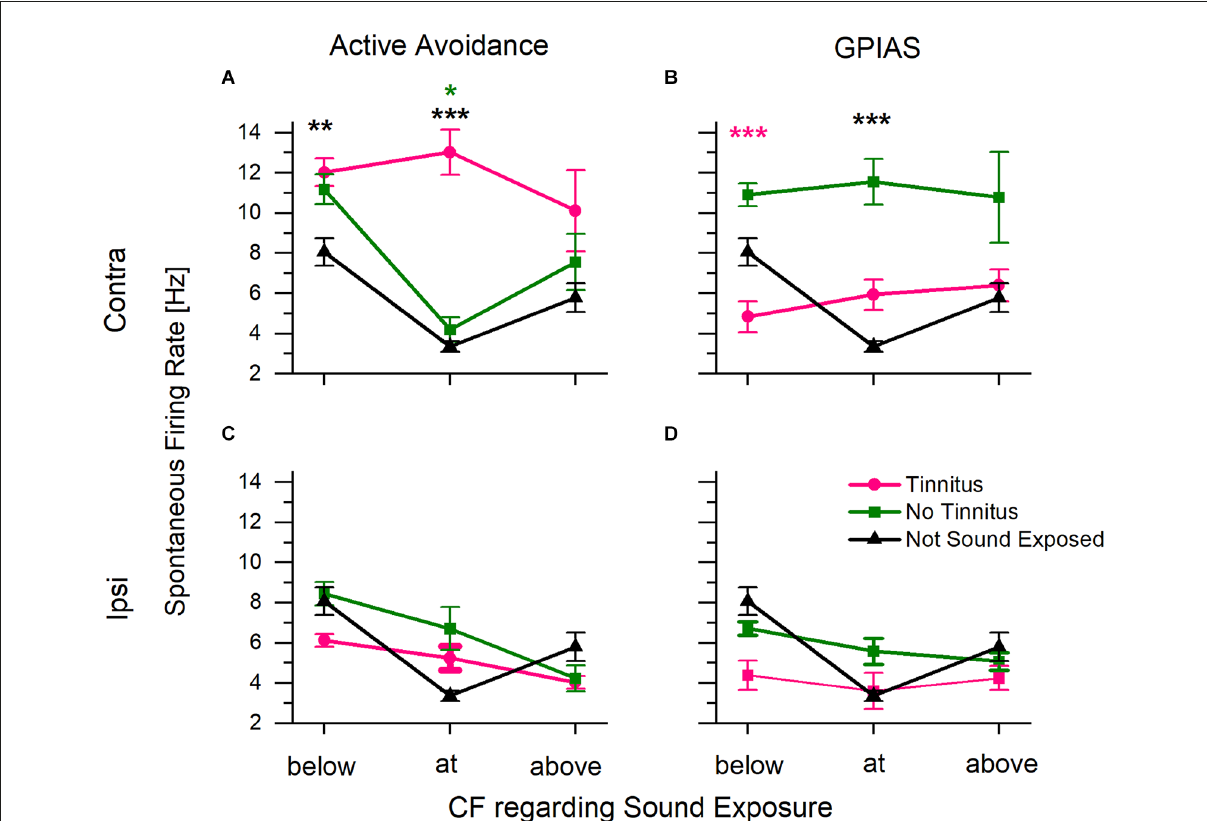
FIGURE7 Average spontaneous firing rate in inferior colliculus collected from multi-channel electrodes. The characteristic frequency (CF) of each channel was determined using the collected frequency response area. Sound exposure frequency was 16 kHz. Data were plotted with the CF regarding sound overexposure. (A) Spontaneous firing rate from the IC contralateral to the sound exposed ear for animals assessed in AA. Includes animals trained in both tests. (B) Spontaneous firing rate from the IC contra to the sound exposed ear for animals assessed in GPIAS. Includes animals trained in both tests. (C,D) Spontaneous activity from the IC ipsilateral to the exposed ear for animals assessed in AA and GPIAS respectively. Tinnitus positive animals in pink, tinnitus negative animals in green, and control, unexposed animals in black. * P < 0.05, ** P < 0.0005, *** P < 0.00005. A Pink * indicates significance from tinnitus, green indicates significance from no tinnitus, and black indicates significance to not sound exposed. AA+ n = 23 (18 trained in both tests, five trained in just AA), AA − n = 17 (13 trained in both tests, four trained in just AA), GPIAS+ n = 8 (four trained in both tests, four trained in GPIAS only), GPIAS − n = 28 (15 trained in both tests, 13 trained in just GPIAS), Control n = 3. N value is the number of